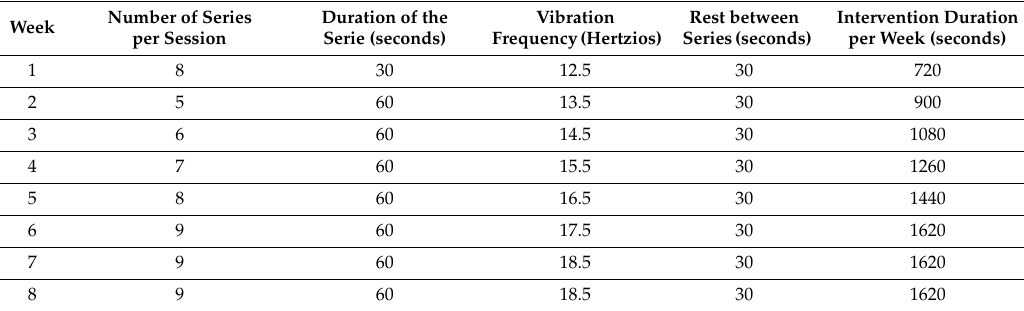
Table 1. Whole-body vibration procedures for each week of the